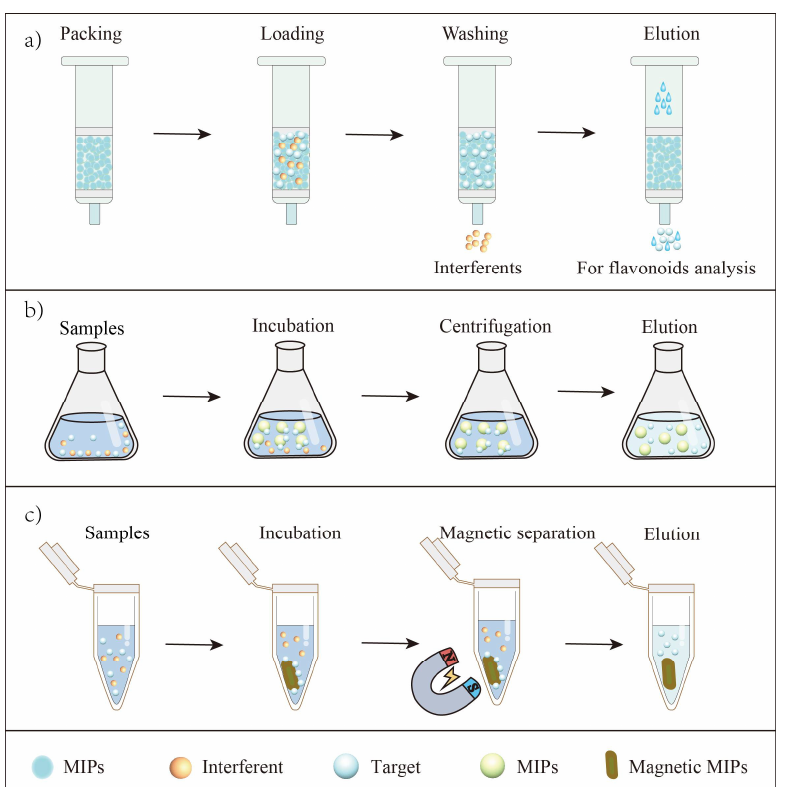
Figure 4. Principles of MIP-based SPE for flavonoid extraction. ( a ) The MIPs towards flavonoids were packed into traditional SPE column for flavonoid extraction; ( b ) The MIPs towards flavonoids were pulled into sample solutions for flavonoid extraction by dispersive SPE; ( c ) The magnetic MIPs were pulled into sample solutions, separating targets and interferents by external magnetic field for flavonoid extraction.